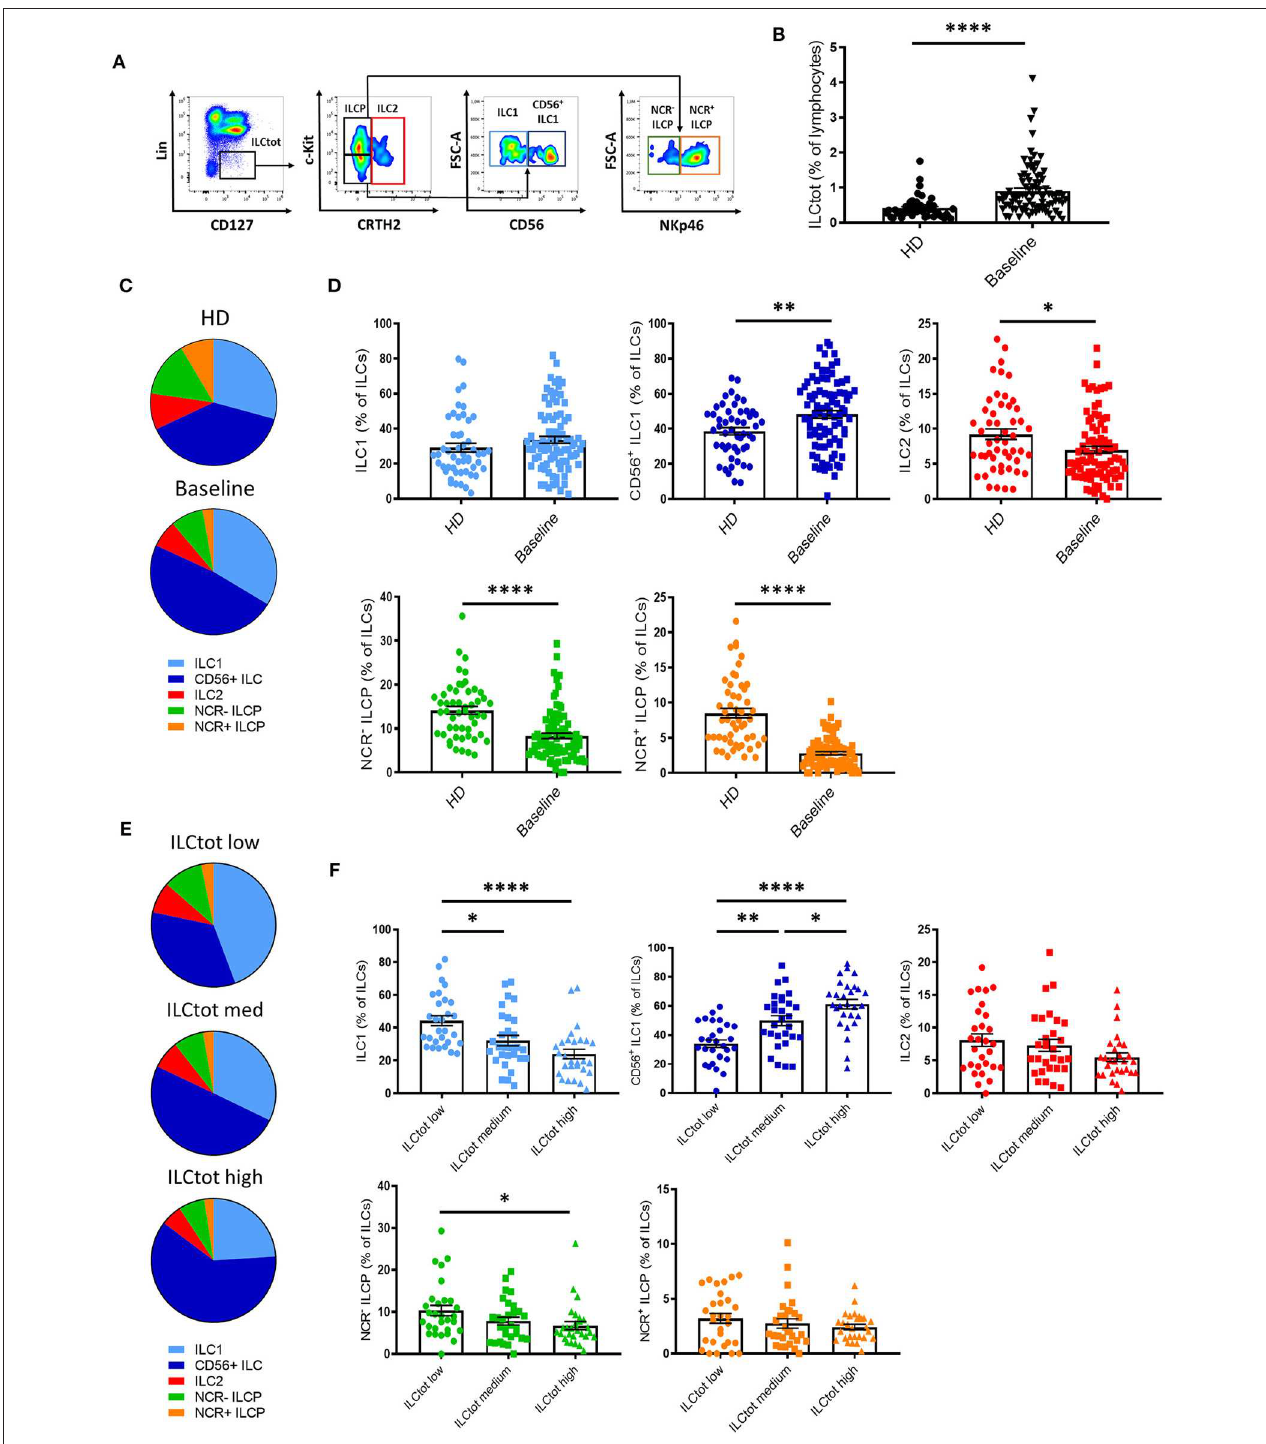
FIGURE 2 | Distribution of ILCs in healthy donors and in metastatic colorectal cancer patients. (A) Flow cytometry gating strategy for ILC subset identifications in PBMCs. (B) Frequencies of ILCtot. ILC subset distributions (C) and frequencies (D) were analyzed by flow cytometry in PBMCs of 51 healthy donors (HD) and 86 chemotherapy-naïve metastatic colorectal cancer patients (baseline). Distribution (E) and frequencies (F) of ILC subsets based on the frequency of ILCtot distributed in the low ( n = 29), medium ( n = 29), and high ( n = 28) terciles. Columns, the means of ILC frequency for each patient; bars, SEM. * p < 0.05, ** p < 0.005, **** p < 0.0001, as determined by Student’s t -test or